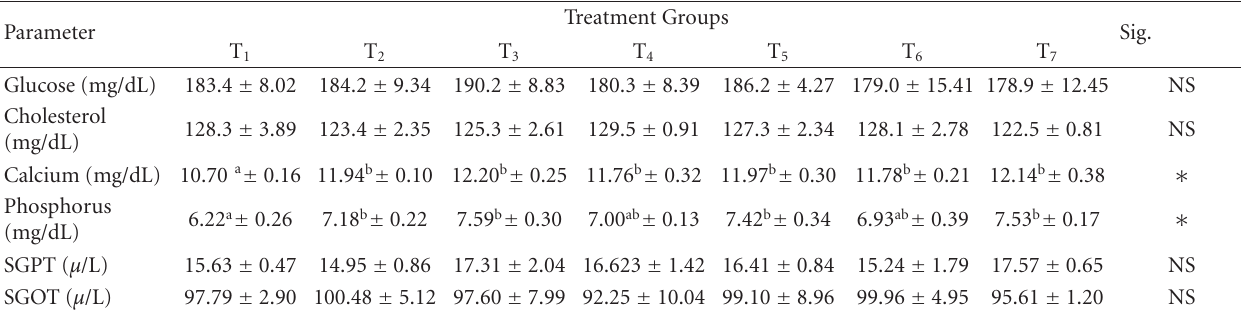
Table 4: E ff ect of organic acid supplementation on serum constituents of broiler chicken.